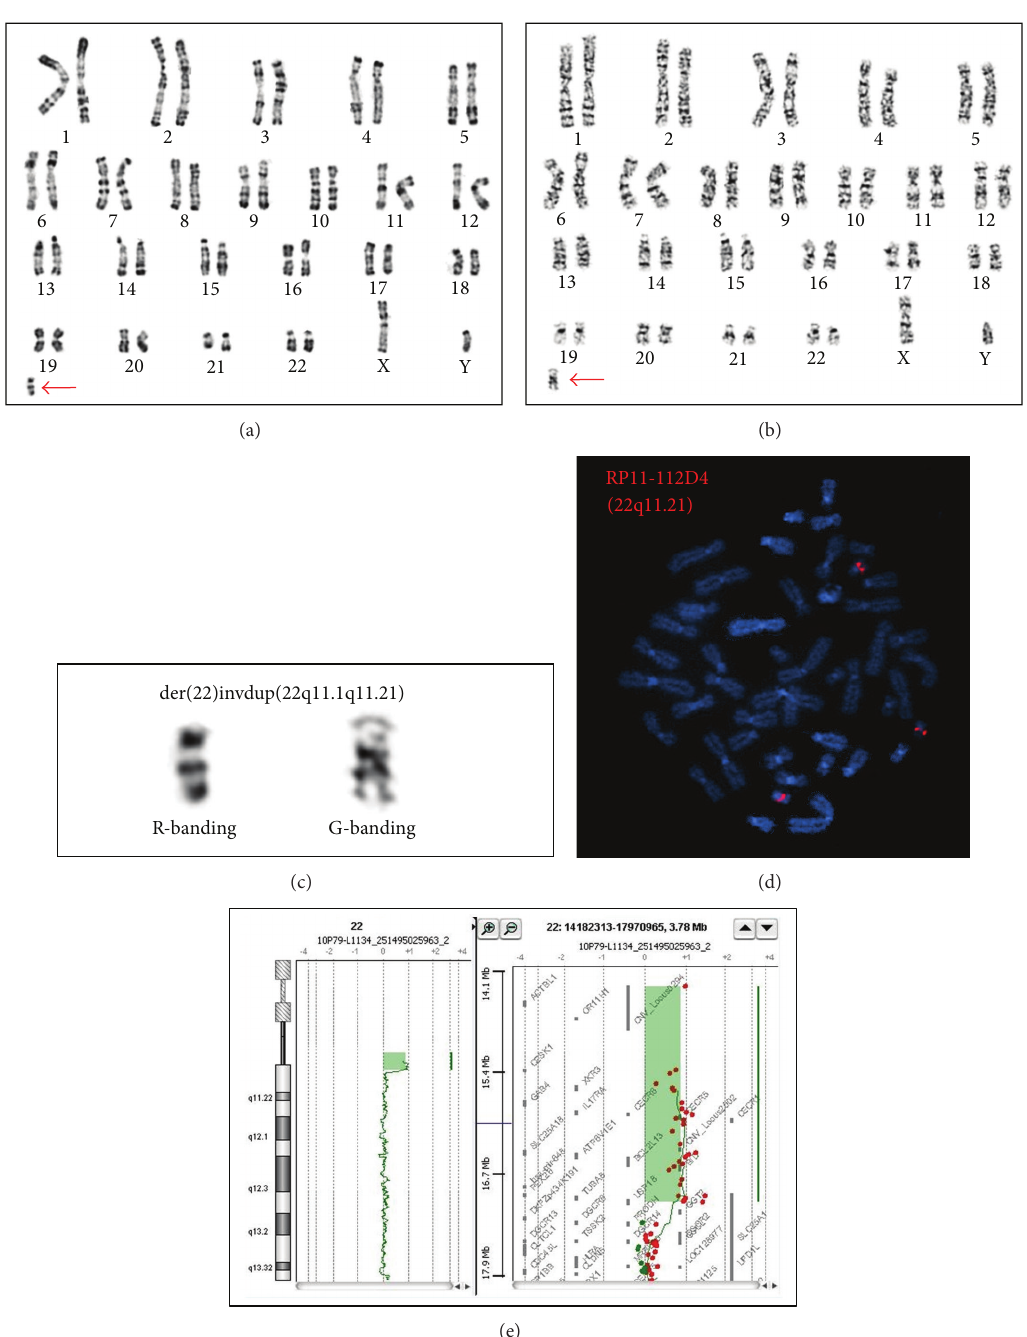
Figure 2: Cytogenetic testing. RHG-banding (a) and GTG-banding (b) karyotypes show the sSMC (red arrow). A zoomed image on the sSMC confirmed that the latter is dicentric and bisatellited (c). FISH analysis with an RP11-112D4 (22q11.21) probe shows two normal signals and one doubled signal, confirming the involvement of the CESCR